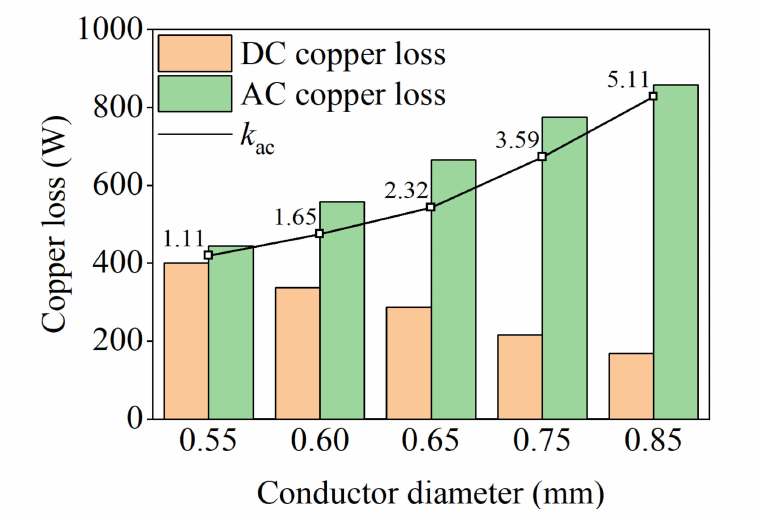
Figure 7. Copper loss and AC/DC copper loss ratio k ac with conductor diameter at 1000 Hz for Case A.